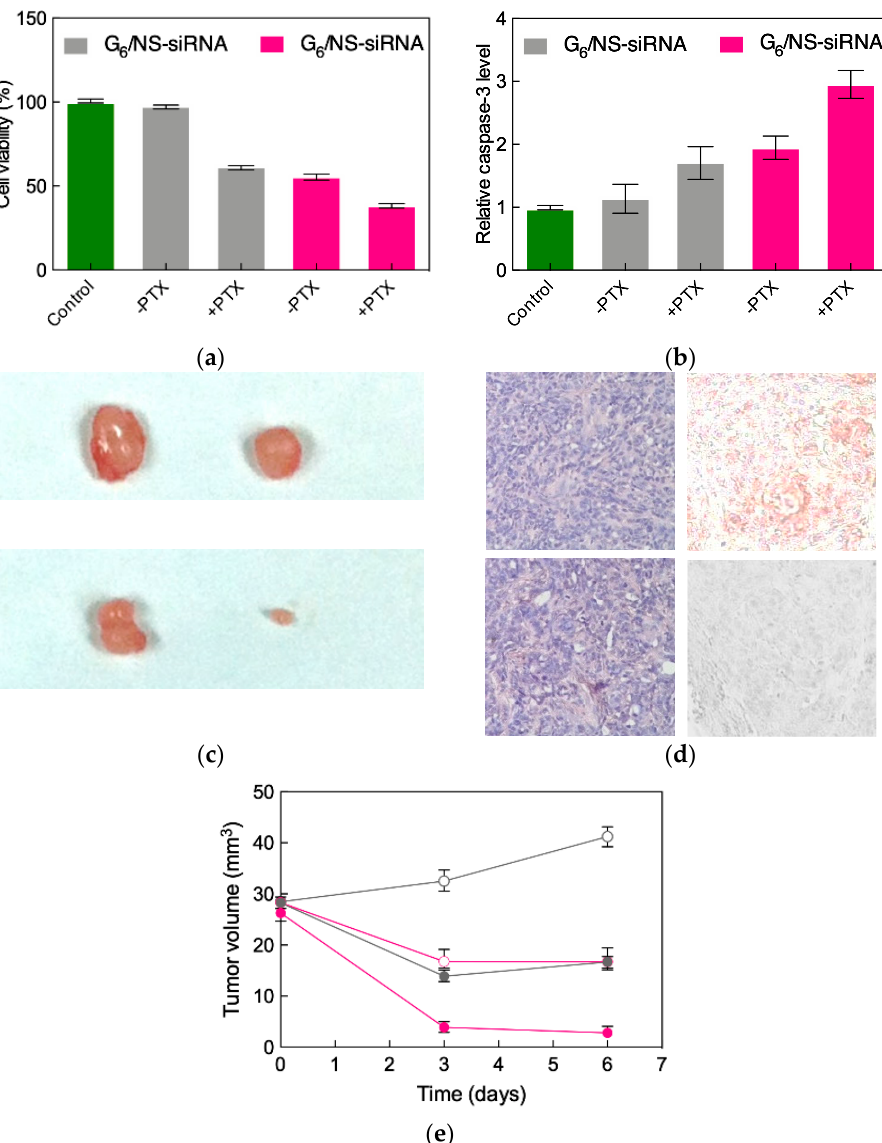
Figure 9. SKOV-3 cell viability ( a ) and relative caspase-3 activation ( b ) after transfection with non-specific (NS) siRNA or AKT siRNA delivered by the G 6 TEA-core dendrimer nanovectors (N/P = 5) alone or in combination with paclitaxel (100 nM). Non-treated cells and β -actin were used as respective controls. ( c ) Tumor volumes from SKOV-3 xenografted mice treated with non-specific (NS) siRNA (top panel, left) or AKT siRNA delivered by the G 6 TEA-core dendrimer nanovectors (N / P = 5) alone (top panel, right) or in combination with paclitaxel (100 nM, bottom panel). ( d ) Drastic reduction of AKT levels in tumor xenografts injected with AKT siRNA G 6 TEA-core dendriplexes ( bottom, left ), and the corresponding histological sample showing sign of necrosis ( bottom, right ), compared with xenografts treated with NS siRNA delivered with the same nanovectors showing no reduction of AKT levels ( top, left ) and no necrosis (top, right). ( e ) Tumor volume during combined treatment of AKT siRNA G 6 TEA-core dendriplexes / paclitaxel (filled hot pink circles) of SKOV-3 mice xenografts, compared with nanodelivered AKT siRNA (open hot pink circles) or paclitaxel alone (filled gray circles). Data for nanodelivered NS siRNA are shown for control (open gray circles).